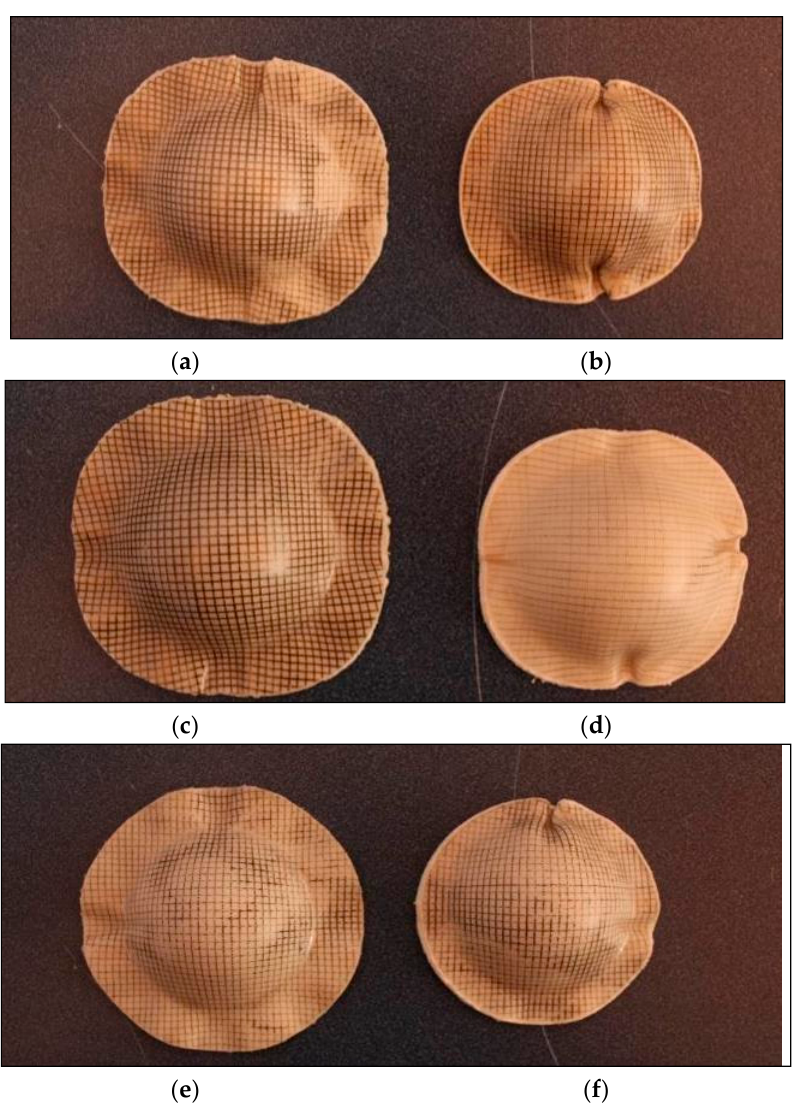
Figure 11. Domes formed from bamboo fabric-PLA composites with different layups and blank sizes. ( a ) Warp, 60 mm/min, 90 mm; ( b ) Warp, 60 mm/min, 80 mm; ( c ) w/f/f/w, 60 mm/min, 90 mm; ( d ) w/f/f/w, 60 mm/min, 80 mm; ( e ) w/45/ − 45/w, 60 mm/min, 90 mm; ( f ) w/45/ − 45/w, 60 mm/min, 80 mm.